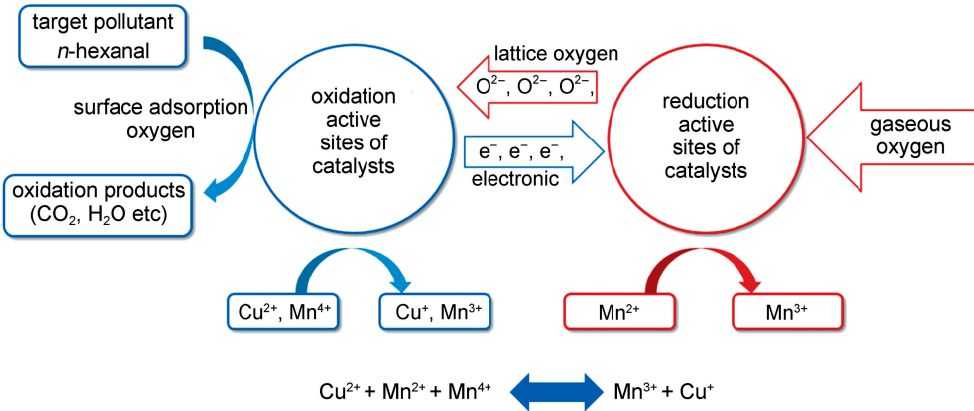
Figure 8. Oxidation-reduction mechanism of n-hexanal over Cu x Mn y /TiO 2 catalyst [169]. Other composite catalysts